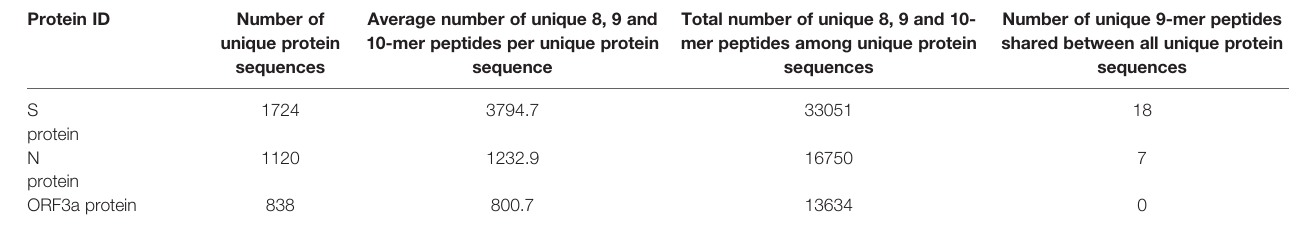
TABLE 2 | Overview of SARS-CoV-2 protein sequence